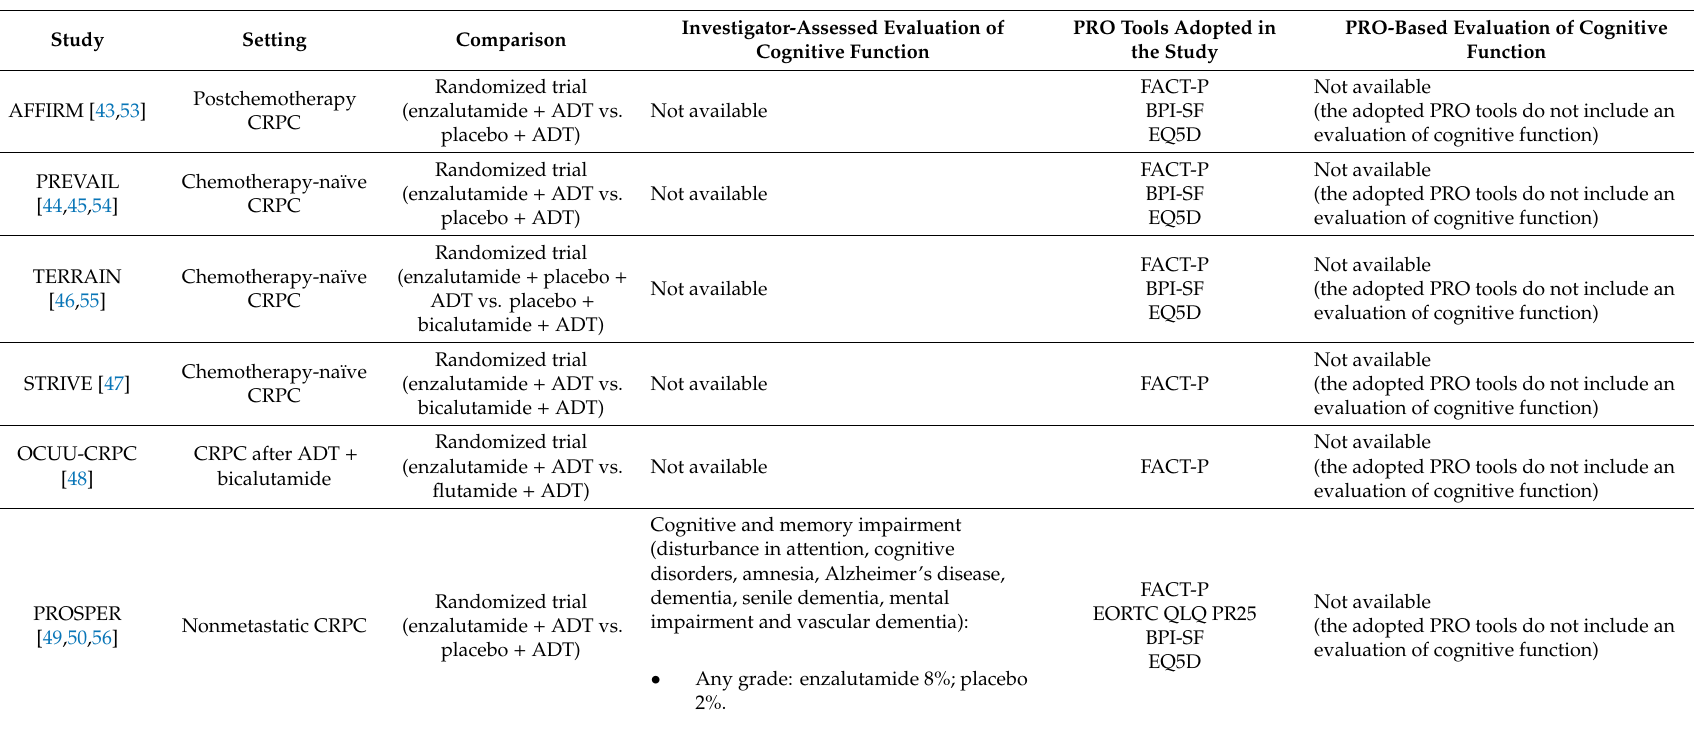
Table 3. Trials testing